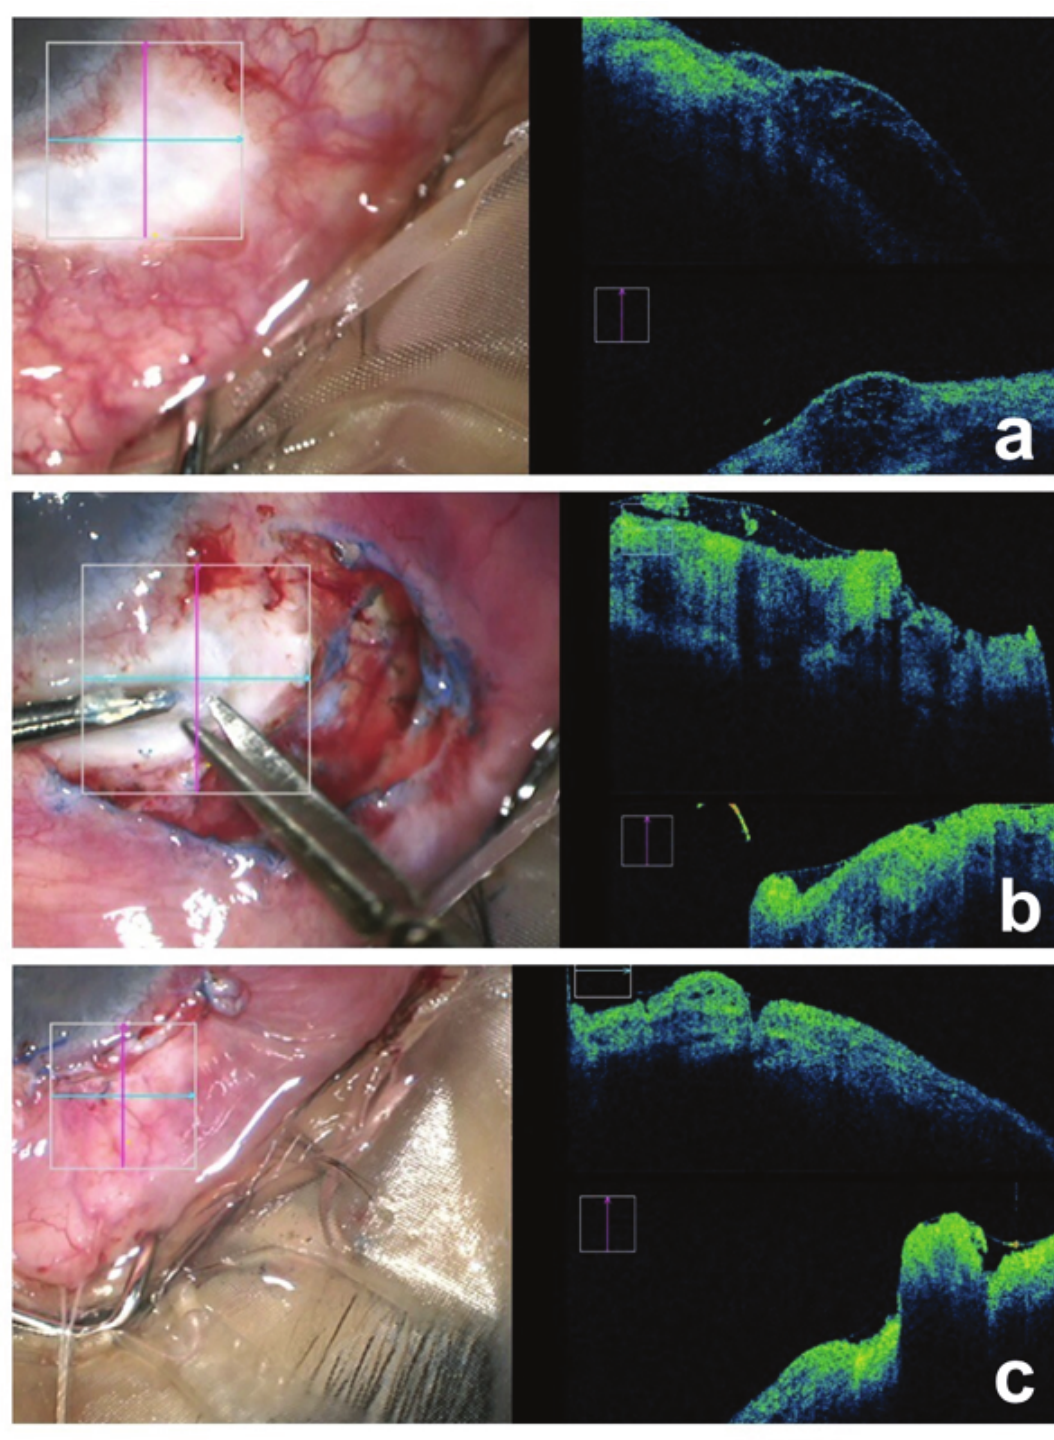
Figure 2. (a) Preoperative clinical photograph of the avascular bleb with the corresponding live iOCT imaging-horizontal scan (blue horizontal line) and vertical scan (pink vertical line) of the bleb area showing large bleb height, a thin epithelium, and multiple hyporeflective spaces in the bleb. (b) Intraoperative clinical photograph showing the lightly stained bleb epithelium with trypan blue dye, being peeled off. The corresponding live iOCT imaging of the bleb area shows an easily visible thin hyper-reflective epithelium. (c) Postoperative clinical photograph showing a bleb covered by adjacent healthy conjunctiva. The corresponding live iOCT imaging of the bleb area shows reduced bleb height, a thick epithelium, and few hyporeflective spaces within the bleb